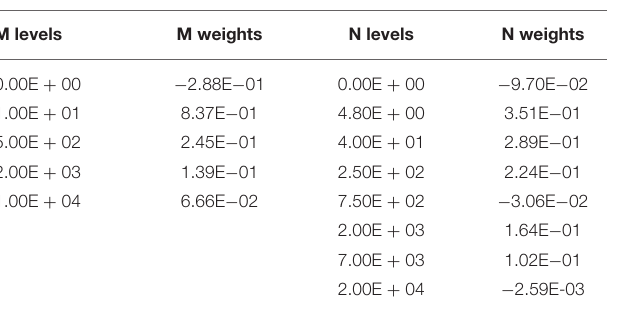
Category Representative